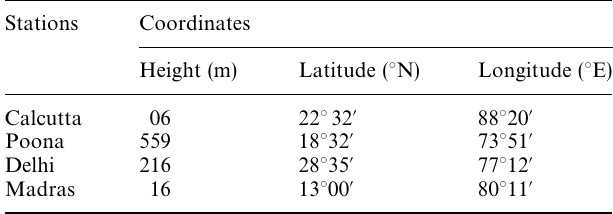
Table 3. Mean daily values of diffuse solar radiation ( (cid:93) 10 (cid:52) ) (in J · m (cid:126)(cid:50) · day (cid:126)(cid:49) ) Calcutta